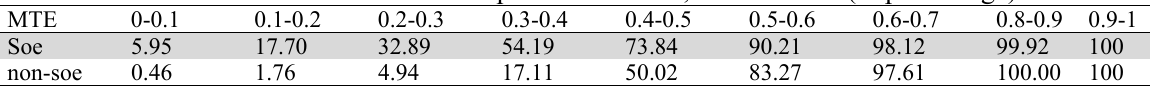
MTE for SOE and for non-SOE in different percentiles 2011, accumulated (in percentage) MTE 0-0.1 0.1-0.2